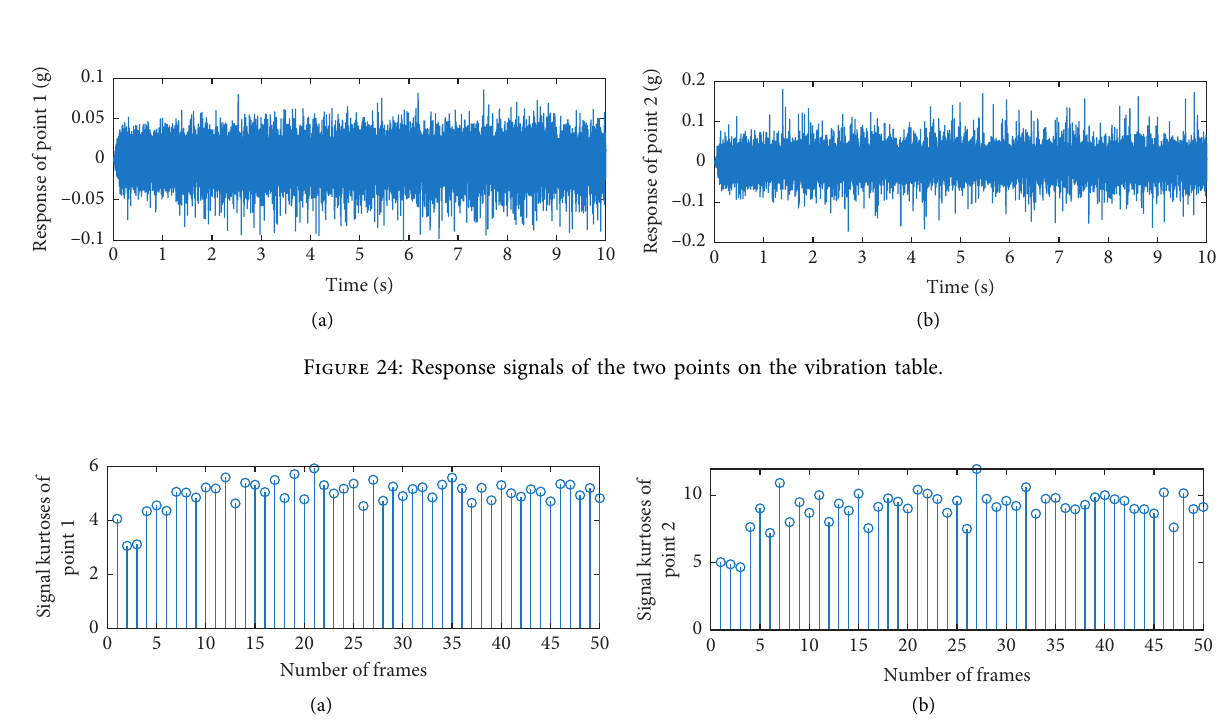
Figure 23: Response spectral density of the two points on the vibration table.